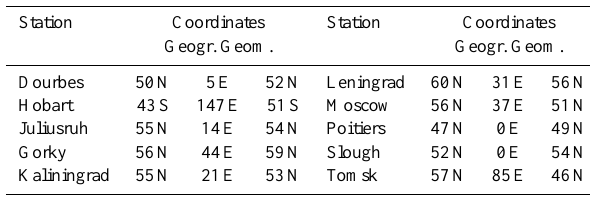
Table 1. List of ionospheric stations mentioned in the paper.